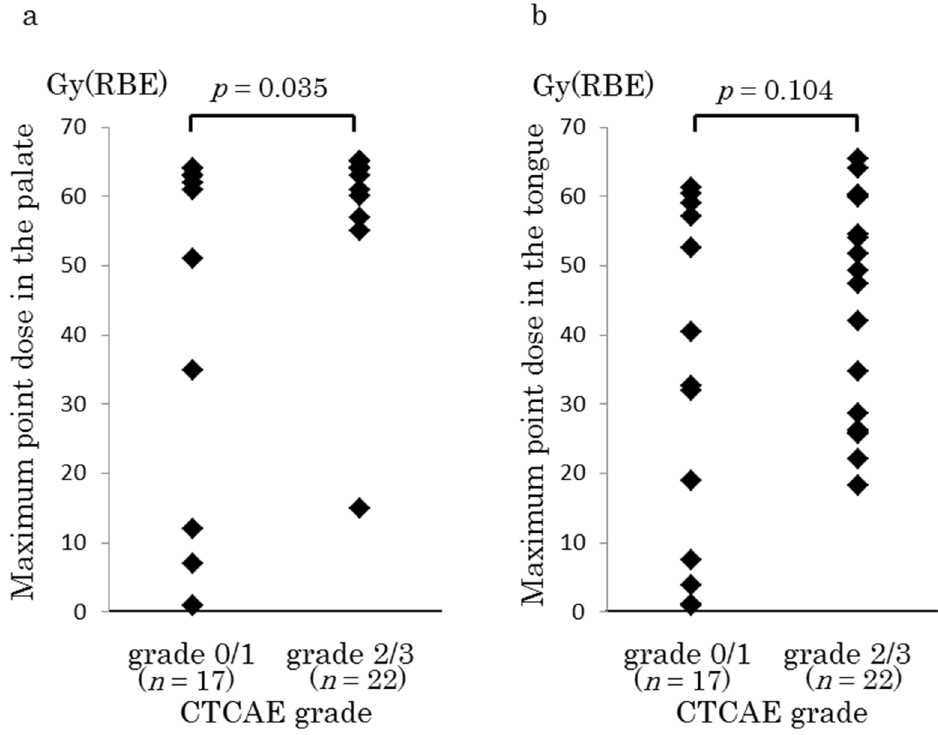
Fig 2. Relationship between the maximum point dose in the oral mucosal dose surface model and acute radiation mucositis (ARM) grade (Common Terminology Criteria for Adverse Events [CTCAE] classification). Maximum doses in the palate (a) and tongue (b) for grade 0 – 1 and grade 2 – 3 ARM. Data are presented as mean ± standard deviation. RBE, relative biological effectiveness.